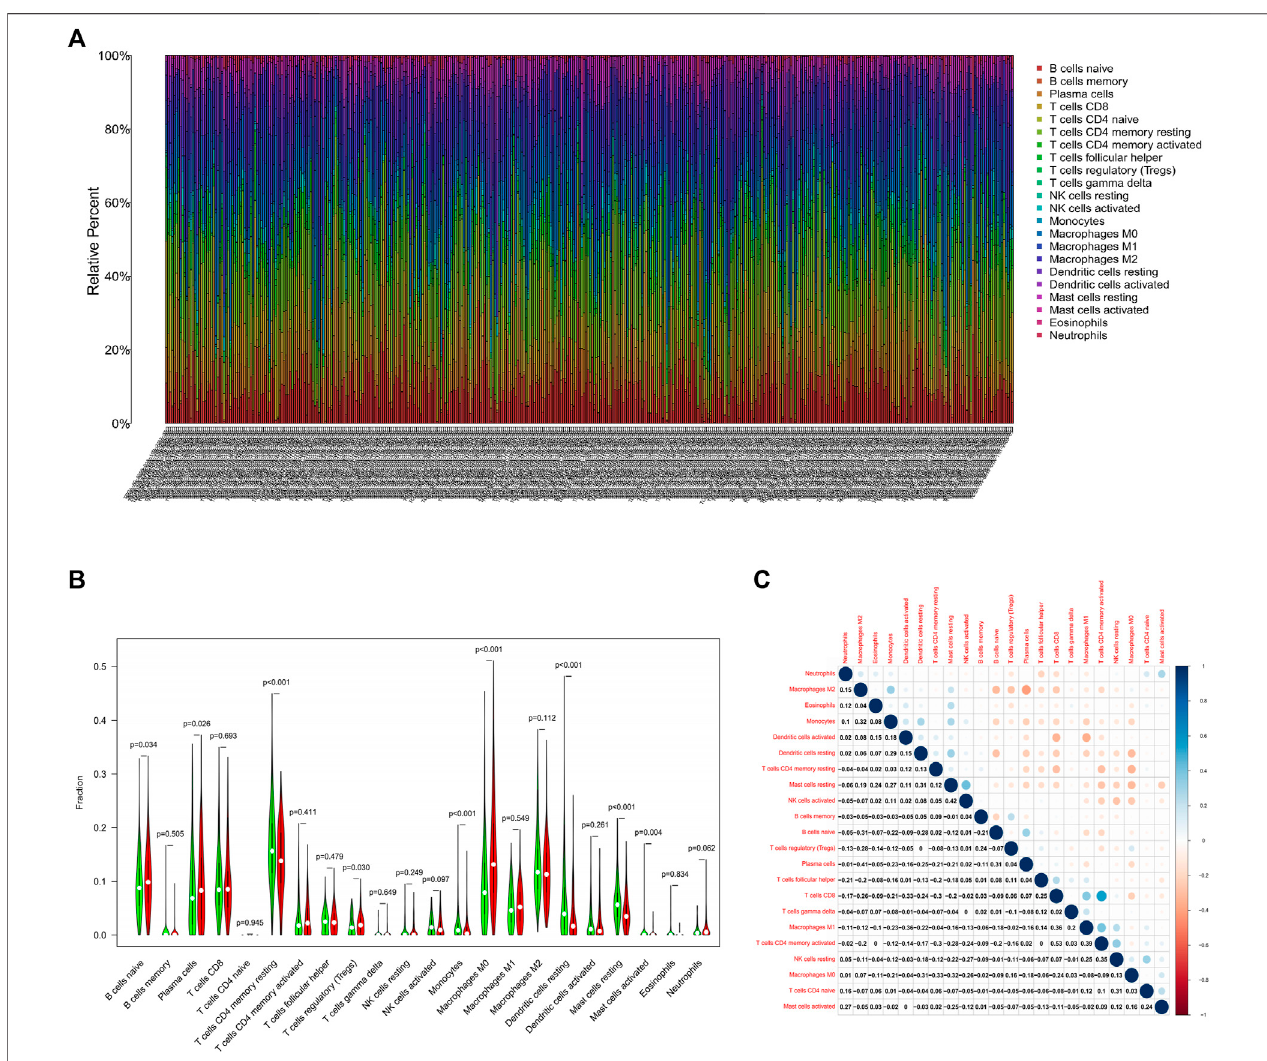
FIGURE 3 | Analysis of the TIME in LUAD. (A) Visualization of immune cell in fi ltration in LUAD. X-axis represents the sample number of 535 patients in the TCGA database ( Supplementary Material S1 ) (B) Differential analysis of in fi ltrated immune cells in LUAD tissues compared to normal tissues. (C) Correlation analysis of in fi ltrated immune cells iin